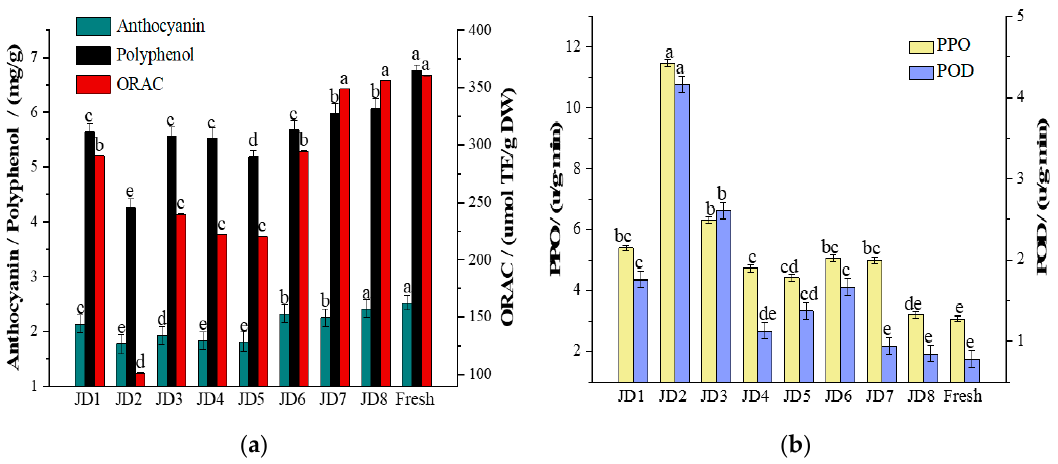
Figure 6. Effects of various thawing methods on the functional components changes of frozen Figure 6. E ff ects of various thawing methods on the functional components changes of frozen blueberries: ( a ) polyphenol, anthocyanin and ORAC value; ( b ) PPO and POD activities. blueberries: ( a ) polyphenol, anthocyanin and ORAC value; ( b ) PPO and POD